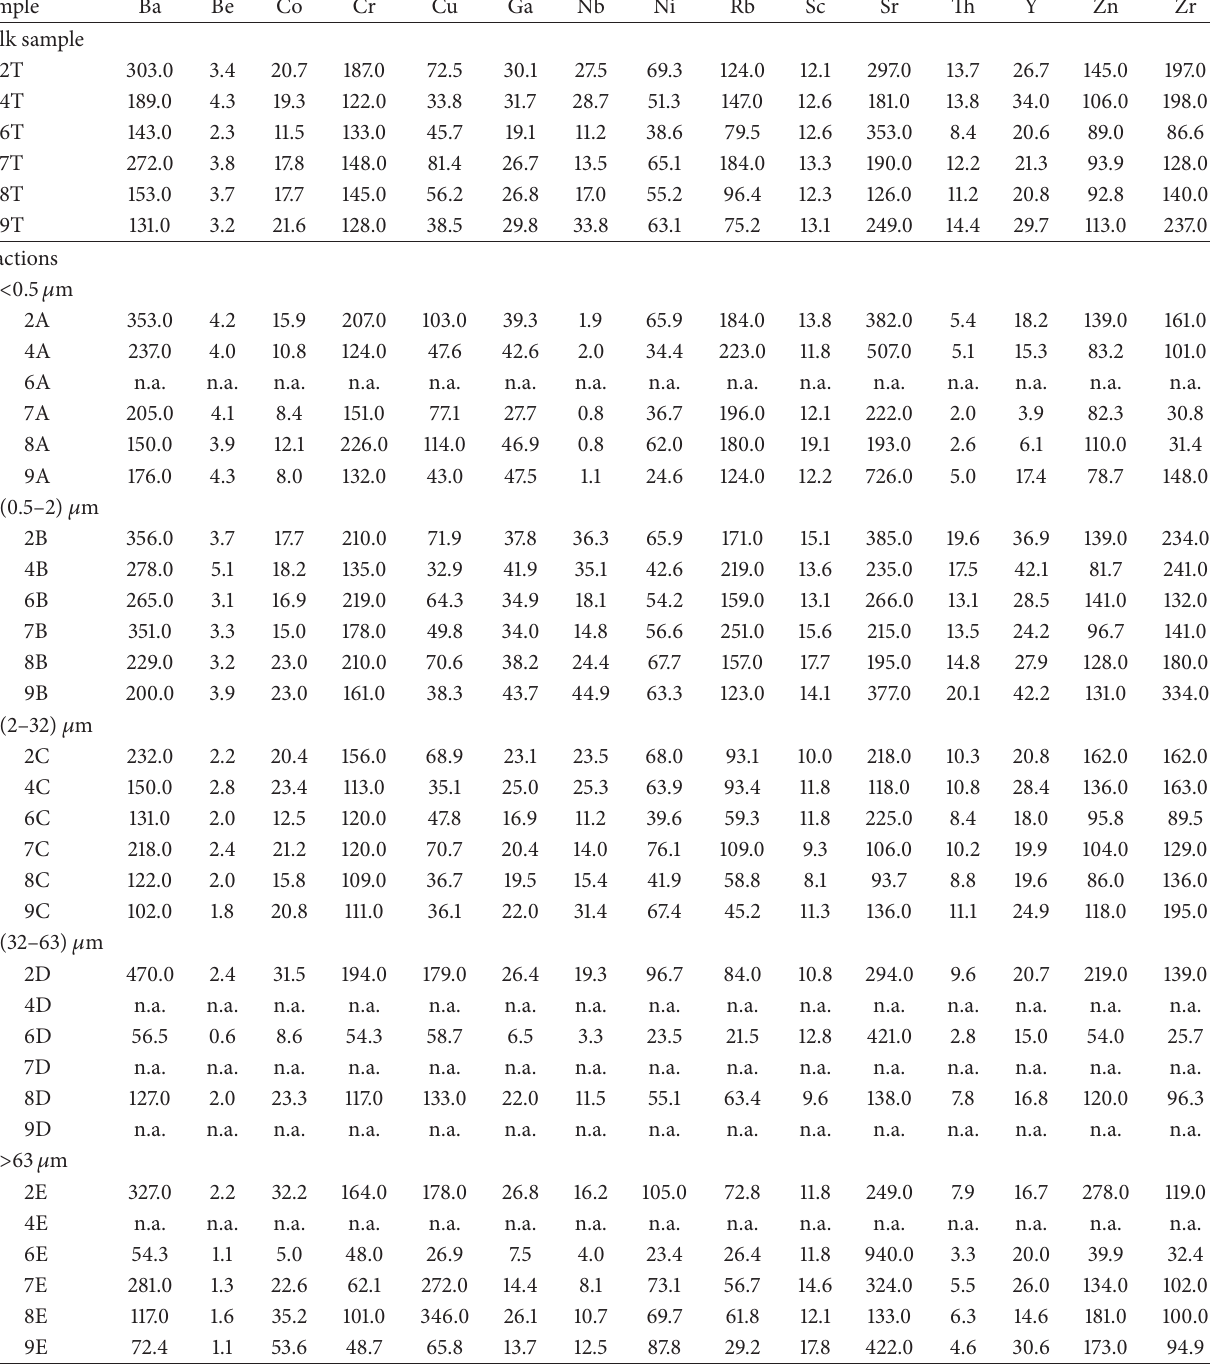
Table 3: The trace elements abundance (ppm) of the bulk sample and different